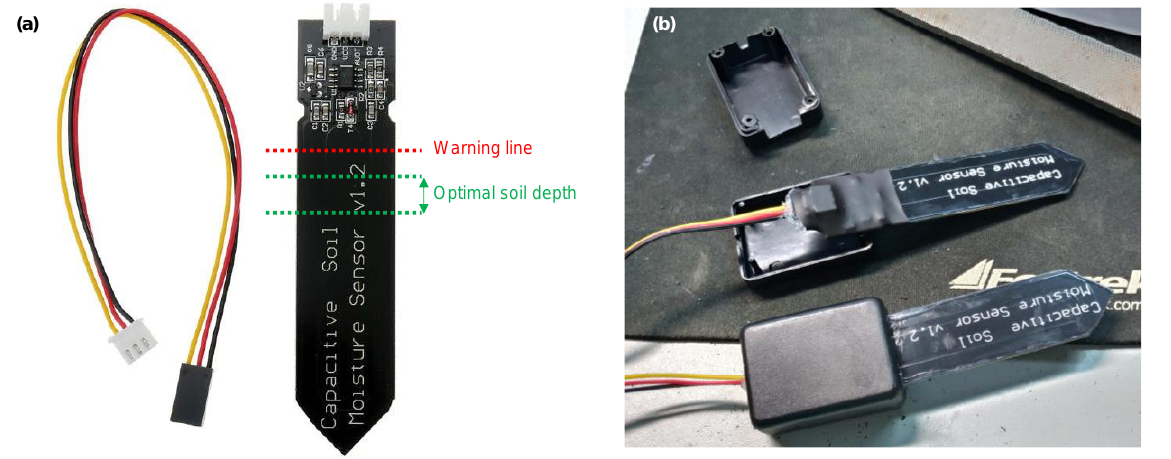
Figure 1. ( a ) The optimal soil contact zone for the SKU sensor for best response and ( b ) protection of its electronic components.